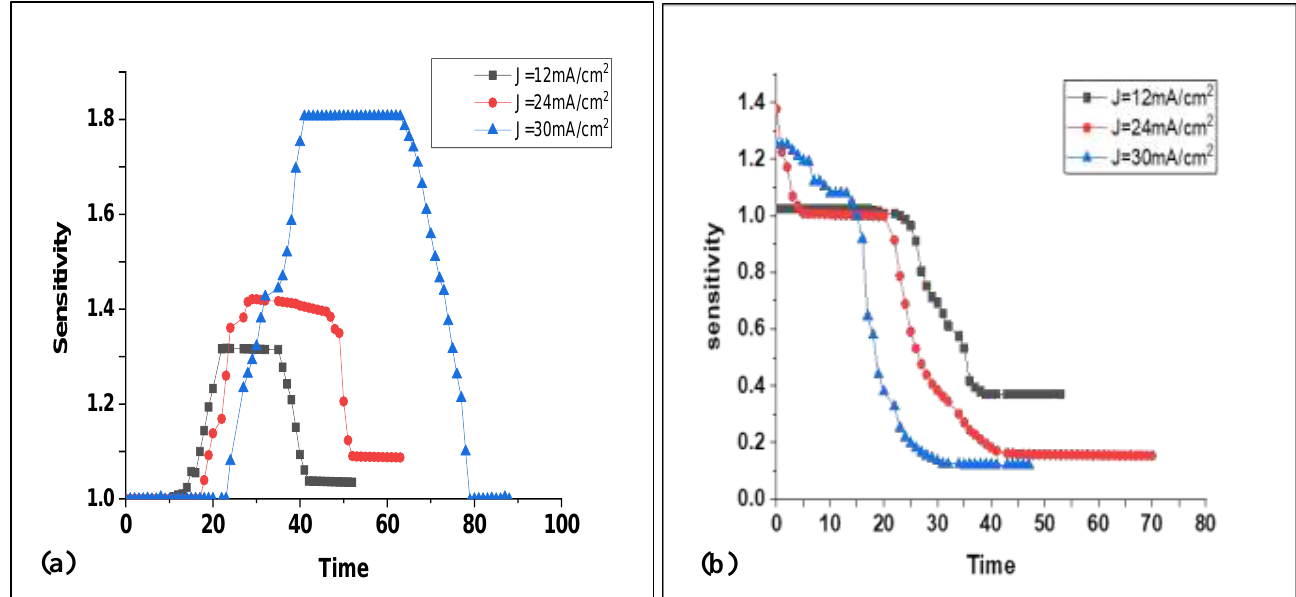
Figure 6: Typical gas sensor responses (Ra / Rg) to a PS with different etching current densities) 12, 24, 30 mA/cm 2 sensor for (a)ethanol and (b)methanol gases at an operating temperature of 60°C.